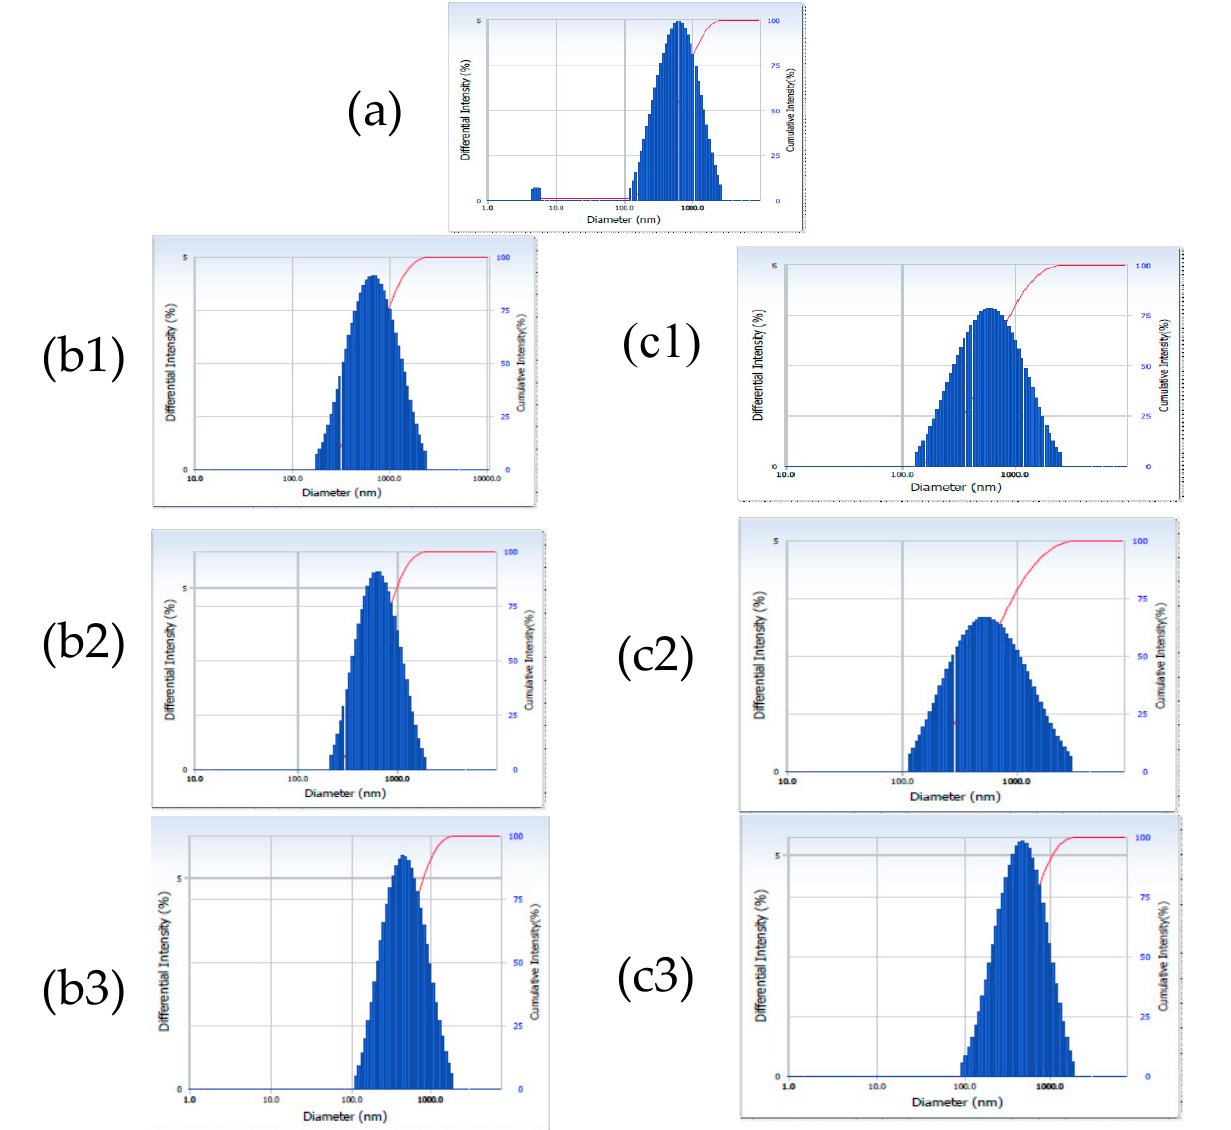
Figure 4. Particle size distribution of blank emulgel suppository dispersed in water (100 mL) at ( a ) zero time, ( b ) after storing at 25 °C and ( c ) 37 °C for 2 h ( b1 , c1 ), 6 h ( b2 , c2 ) and 24 h ( b3 , c3 ), respec- tively.